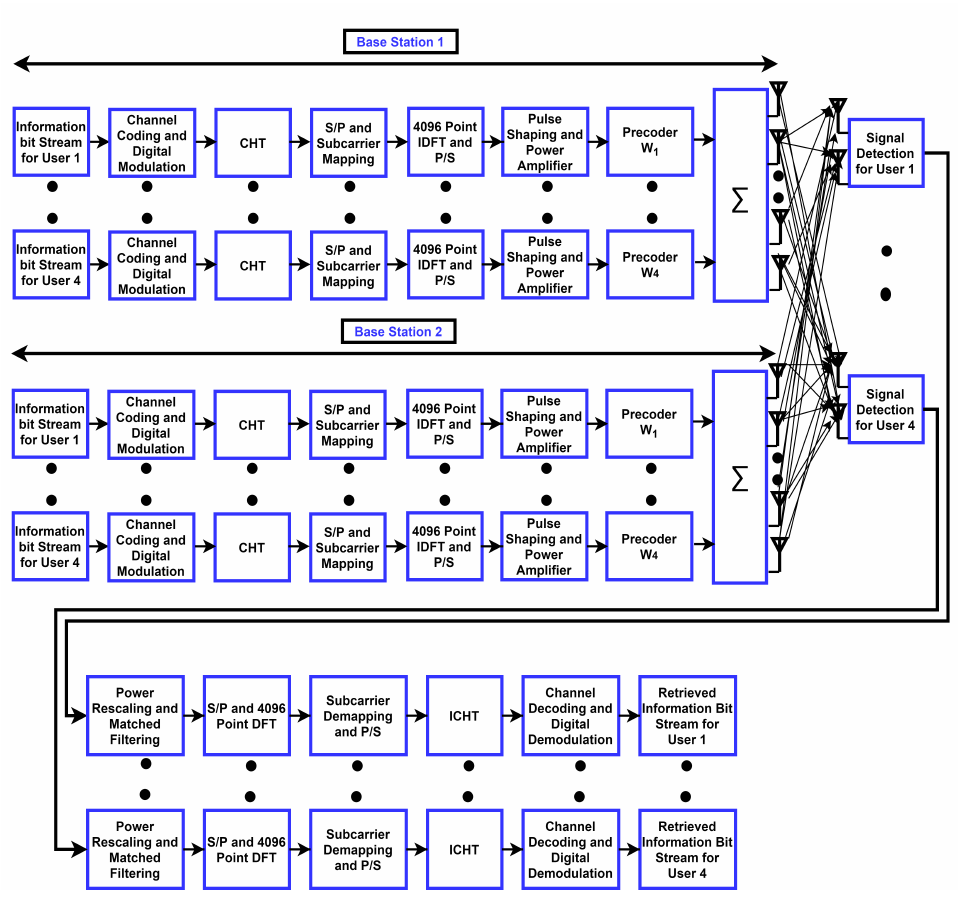
Figure 3. Block diagram of CoMP-JT-based downlink CP-free multiuser OFDM communica- tion